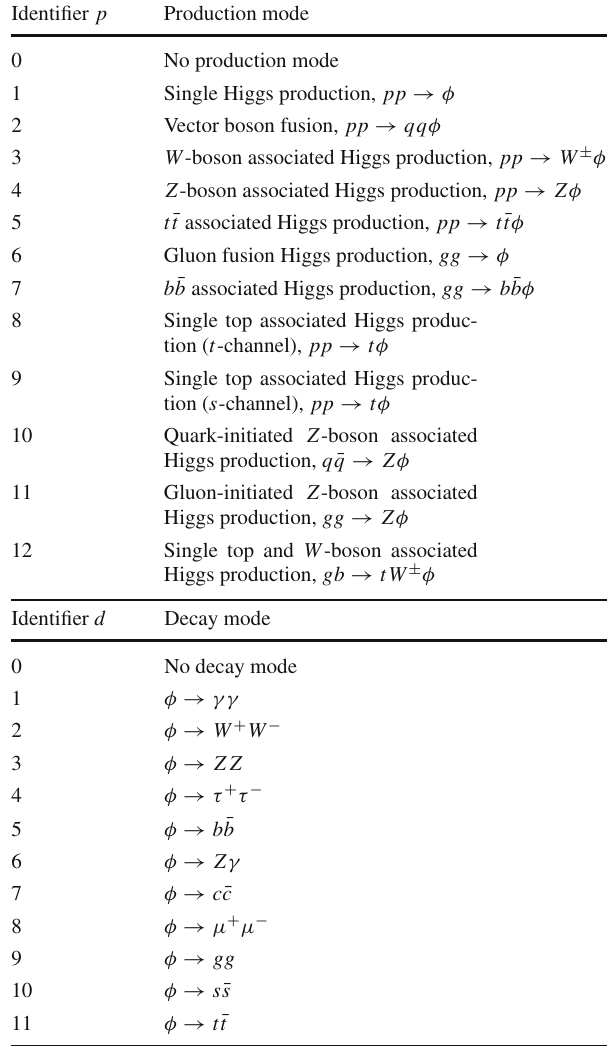
Table1 Productionanddecaymodeidentifiers, p and d ,forthevarious Higgsproductionanddecayprocessesincludedin